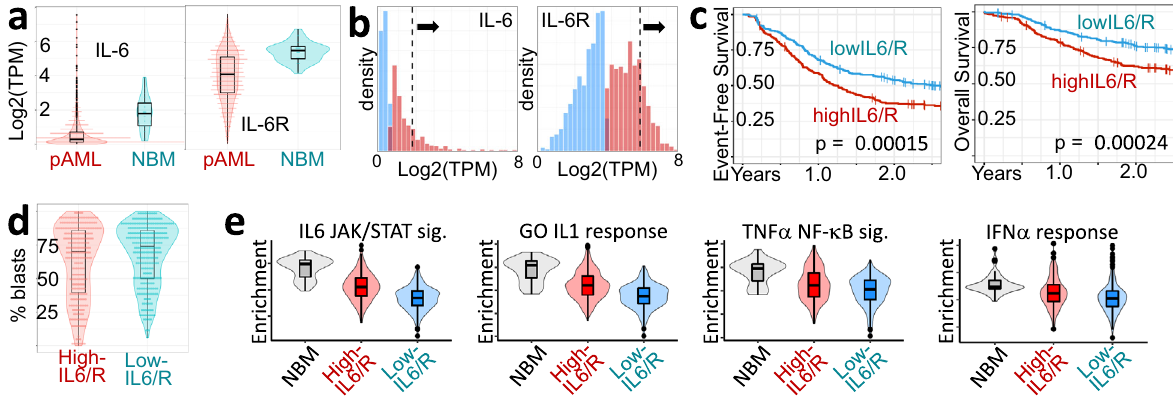
Fig. 1 | Pediatric AML diagnostic samples with higher IL-6 or IL-6R expression have higher multi-cytokine signaling in the bone marrow (BM) and poorer 2-year outcomes than patients with low levels of bone-marrow IL-6 and IL-6R mRNA.a pediatricAMLBM IL-6 and IL-6R expressionlevelsarerarelyhigherthanin normalBM. b Gaussianmixturedeconvolutionof IL-6 and IL-6R expressionintolow andhighgroups(blueandredhistograms,respectively).Thetop25%ofsamplesin the higher-expression groups (black arrows and dashed lines) were selected as having unusually high IL6/IL6R expression levels. c Kaplan – Meier Event-Free and